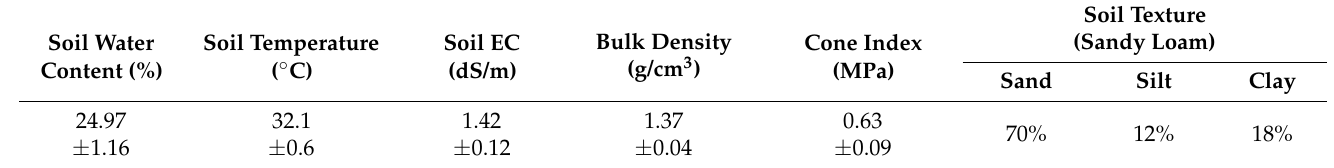
Table 2. Major soil properties of experimental